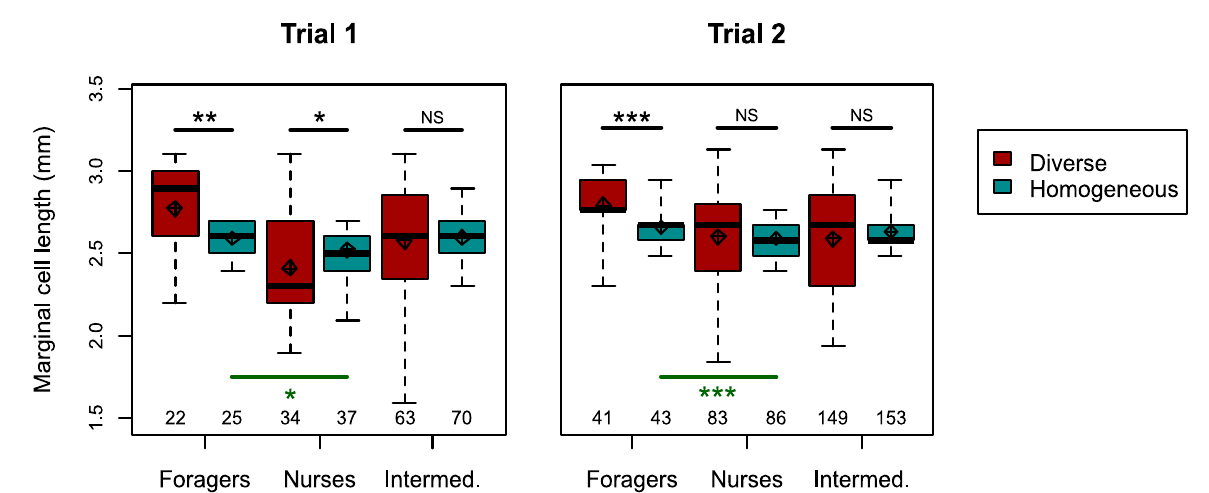
Figure 4. Nursing and foraging performance in size–diverse and -homogenous colonies. Red symbols—individuals in diverse colonies; blue symbols—individuals in homogeneous colonies. Trial 1—left column; Trial 2—right column. Upper row: the relationship between total foraging and nursing (brood tending) observations per worker. Lower row: foraging: nursing ratio as a function of worker body size (wing marginal cell length). In order to display multiple data points in the same position, a small amount of horizontal and vertical random noise has been added to each data point.